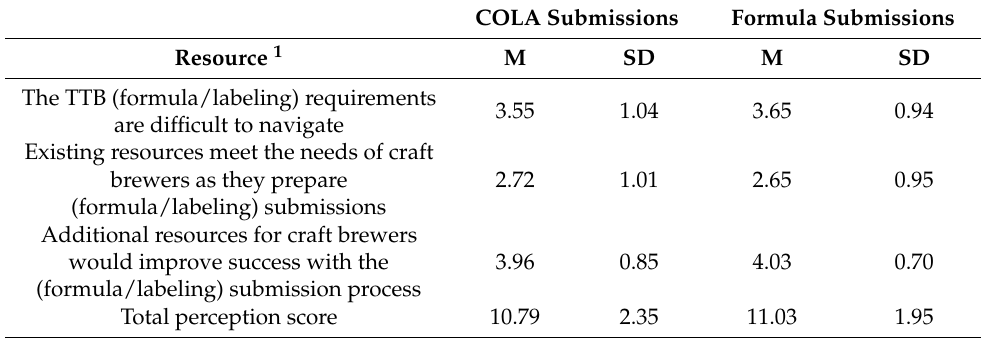
Table 13. Brewer Perceptions: Regulatory Navigation and Available Resources.